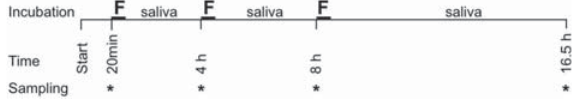
Figure 3- Schematic timeline of the experimental conditions (F represents 45 min feeding periods with saliva/mFUM 30/70). Between feedings, the discs were incubated in saliva